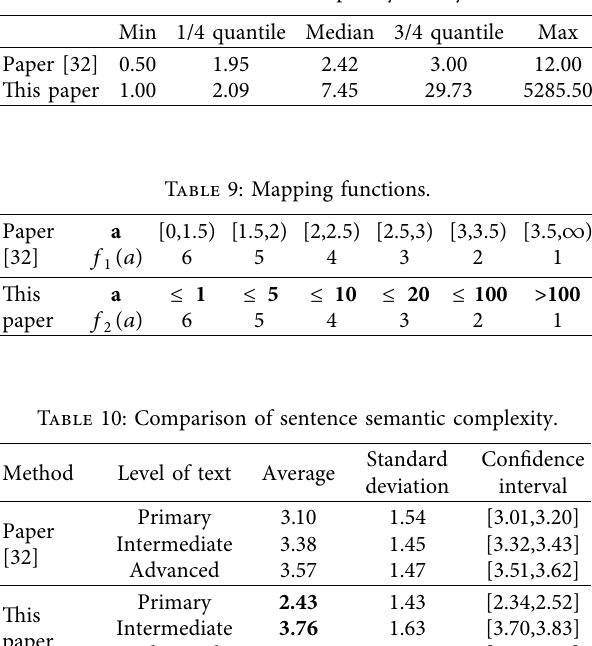
Table 8: Sentence semantic complexity in Boya Chinese.